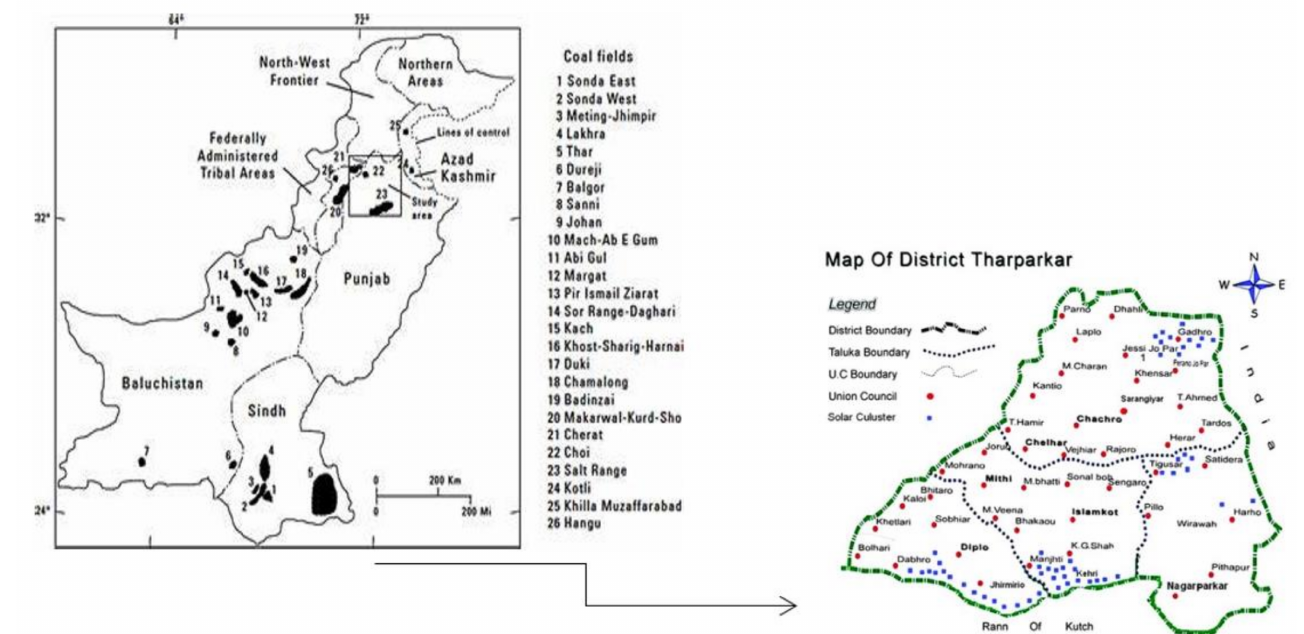
Figure 1. Coal fields in Pakistan and detailed map of district